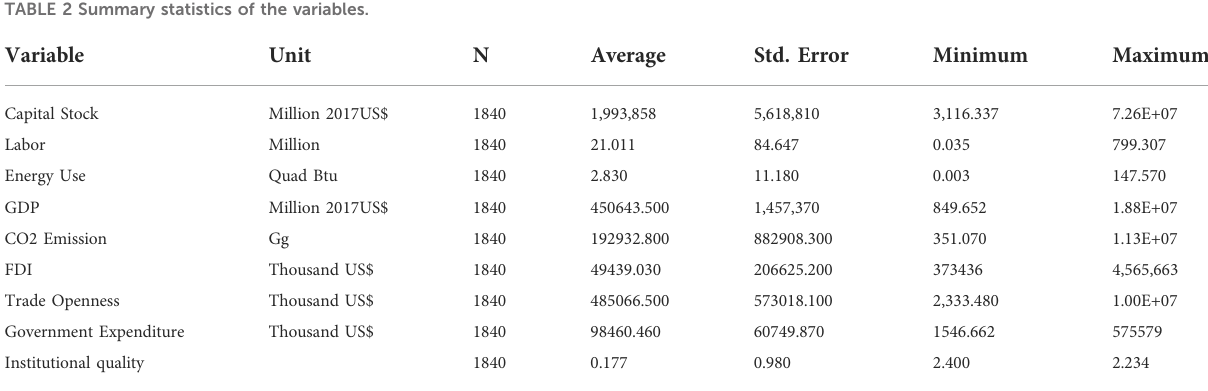
TABLE 2 Summary statistics of the variables.